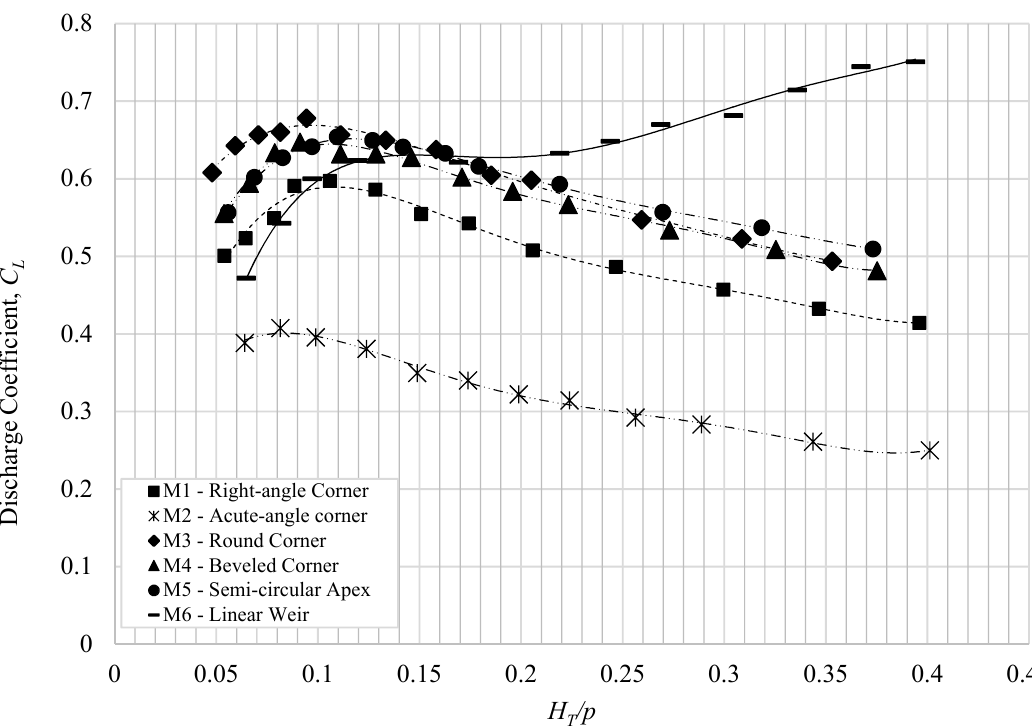
Figure 9. Variation of discharge coefficient ( C L ) versus H T / P for all physical models.